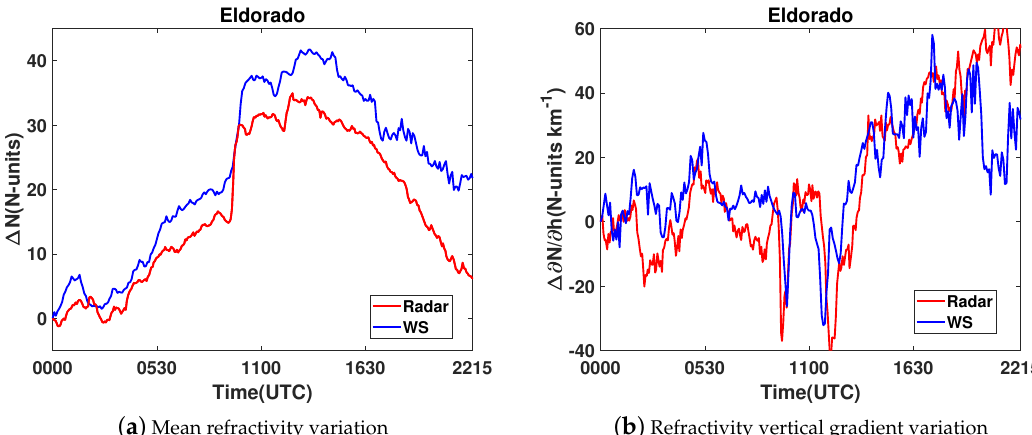
Figure 7. Mean refractivity variation at the radar height and refractivity vertical gradient variation obtained from radar phase measurements at the Eldorado test